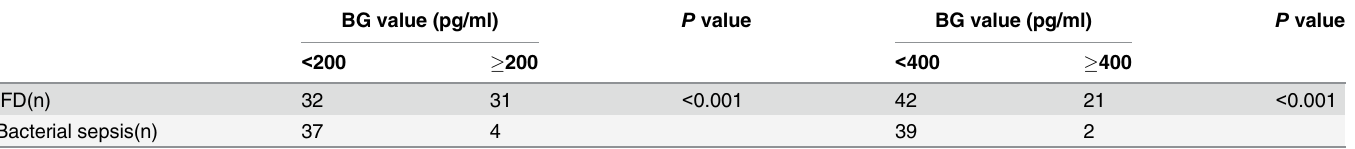
Table 3. IFD and bacterial sepsis by BG value.